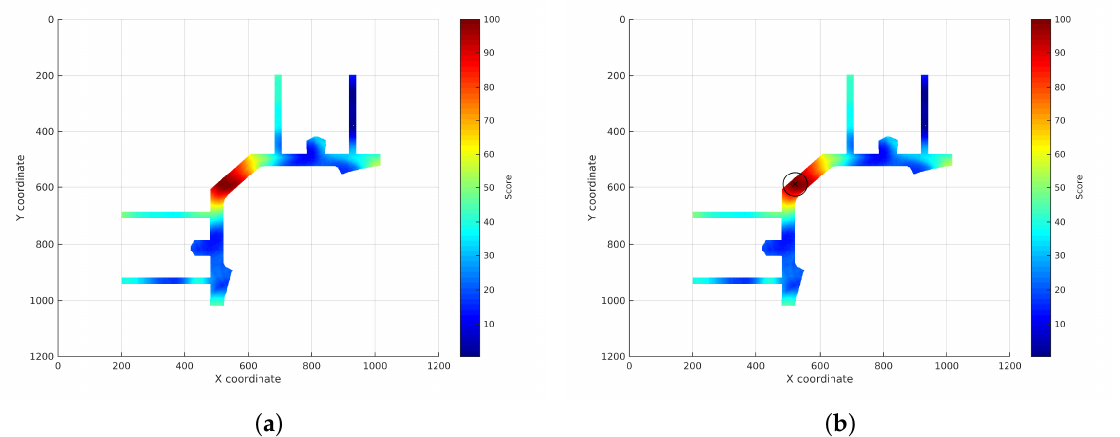
Figure 5. Resulting surface applying a mask of the environment to allow only reachable coordinates. ( a ) Masked surface to the reduce allowed locations; ( b ) location of the